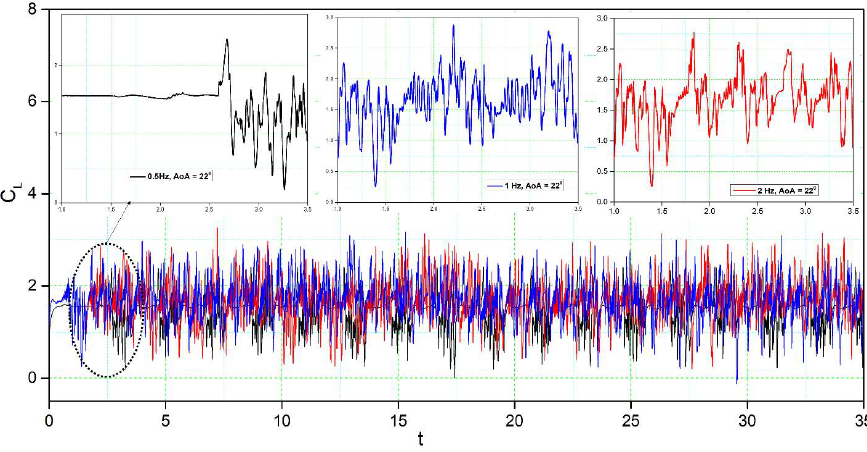
Figure 14. Lift coefficient transient responses for DMLE airfoil at 0.5 Hz, 1 Hz, and 2 Hz. Biomimetics 2023 , 8 , 51